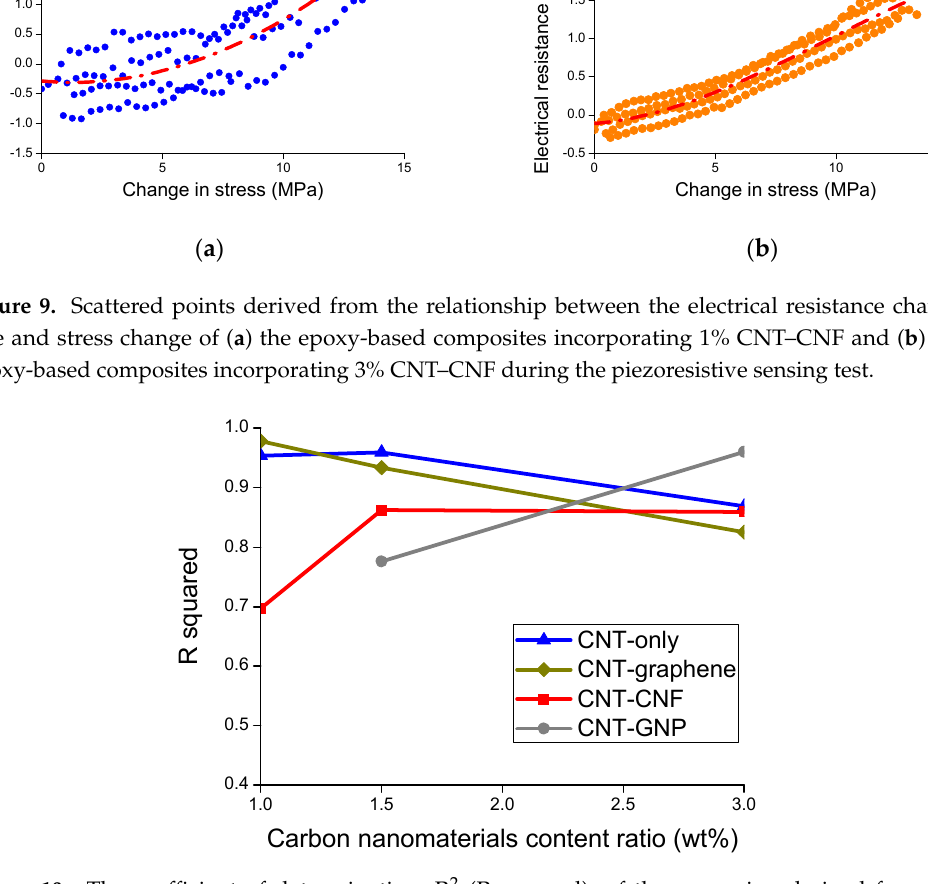
Figure 10. The coe ffi cient of determination, R 2 (R squared), of the regression derived from the relationship between the electrical resistance change rate and stress change during the piezoresistive sensing test of the epoxy-based composites incorporating CNT-only, CNT–graphene, CNT–CNF, or CNT–GNP.